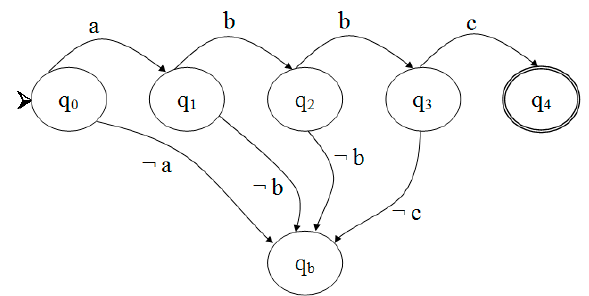
Figure 3. Programmed automaton used to recognize rectangles.